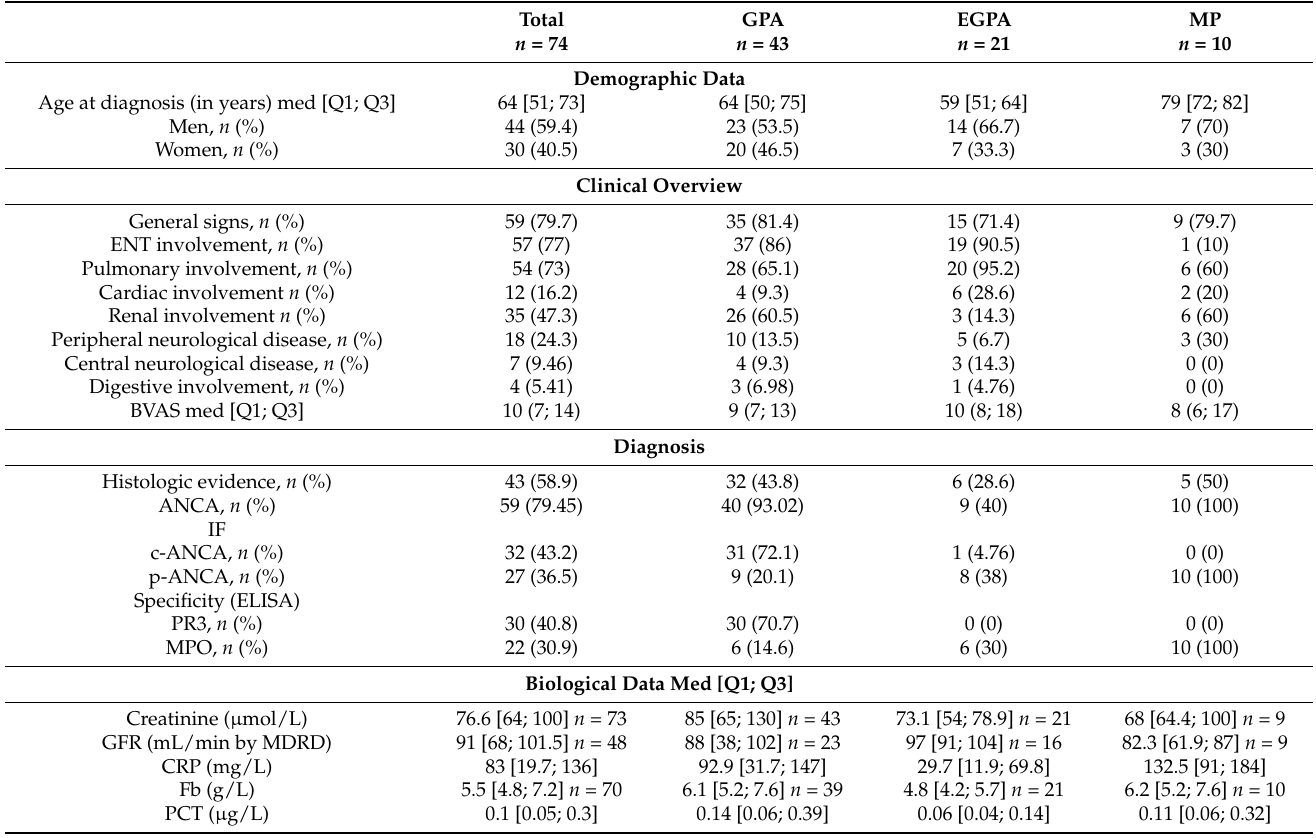
Table 1. Clinical and laboratory characteristics of the 74 patients at AAV